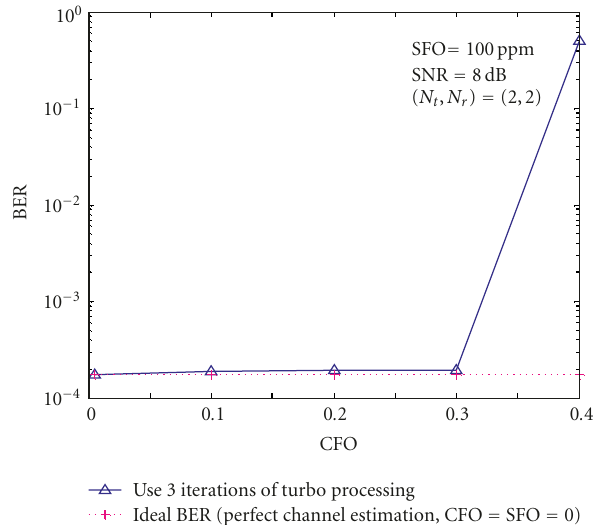
Figure 10: BER performance of the proposed turbo joint channel estimation, synchronization, and decoding scheme under various CFO